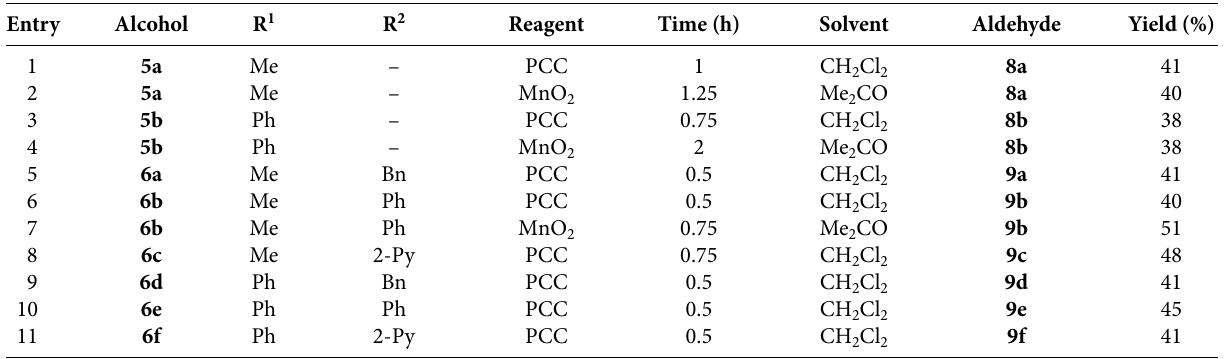
Table 3. Oxidation of primary alcohols 5a,b and 6a–f to aldehydes 8a,b and 9a–f , respectively. Entry